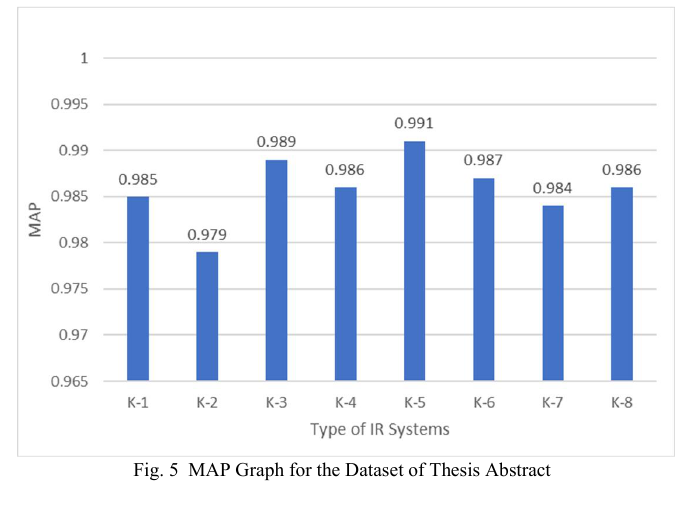
Fig. 5 MAP Graph for the Dataset of Thesis Abstract